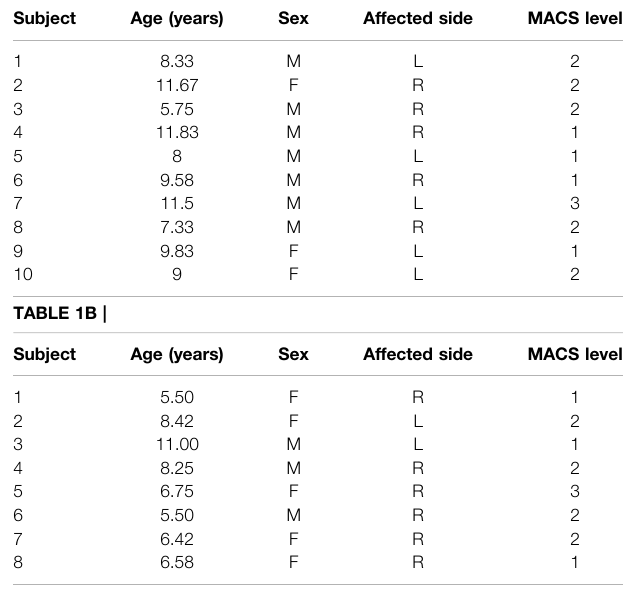
TABLE 2A | (A) Range of motion of upper limb joints and trunk during 20 min gameplay (B) Questions and results of the gameplay